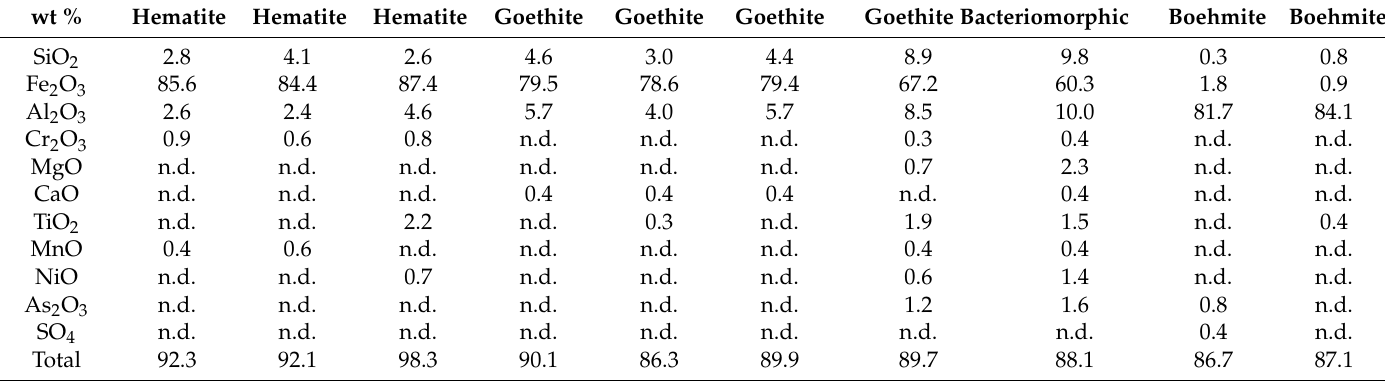
Table 4. Representative SEM-EDS analyses of Fe-Al (hydroxyl) oxides from bauxite laterite (Profile I, Samples P1.2–P3.2, Figure 5).